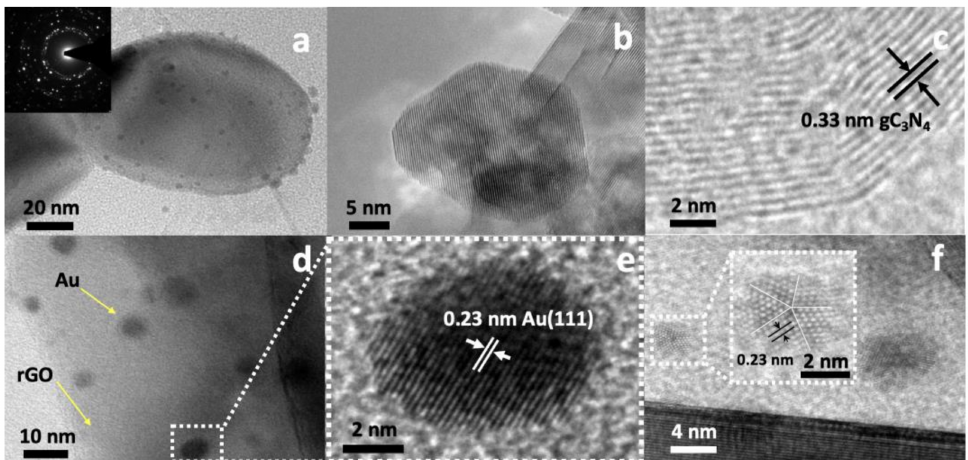
Figure 1. ( a ) SEM image of 10%Au@ZnONPs, ( b ) the corresponding elemental mapping of Zn and ( c ) Au. HV (20 keV), magnification 2500 × , and WD (15 mm).